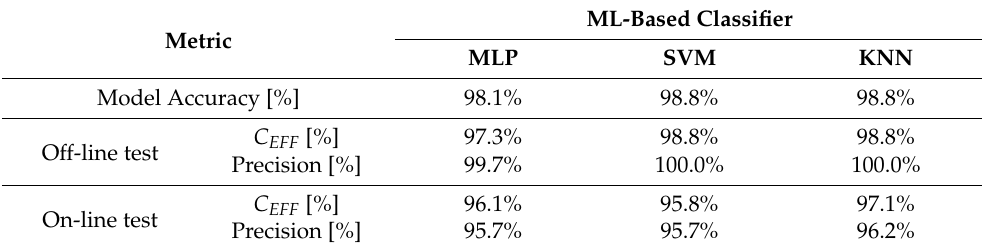
Table 4. The comparison of the analyzed ML-based classifiers.